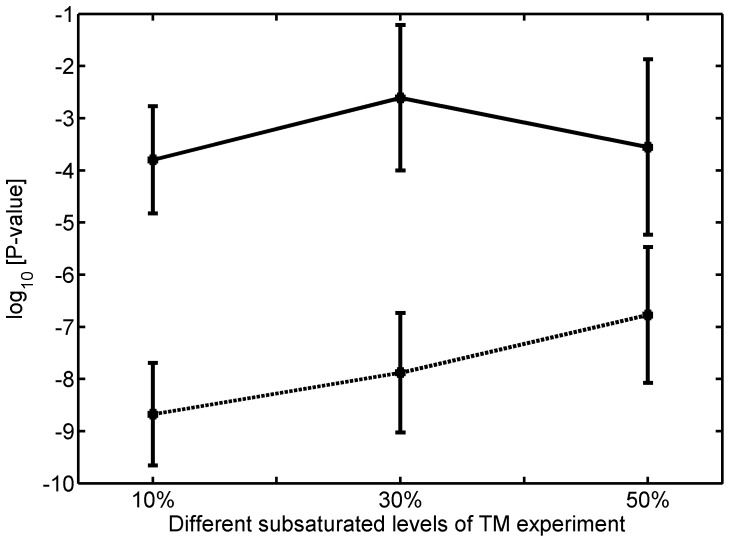
Robustness of our model at subsaturation levels of transposon insertions.The dashed line showed p-values of the Fisher’s exact test to examine whether the true essential rate in PNTmEs is significantly lower than that in the original TmEs set. Similarly, the solid line showed p-values of the Fisher’s exact test to examine whether the true essential rate in our PETmNs is significantly higher than that in the original TmNs set.